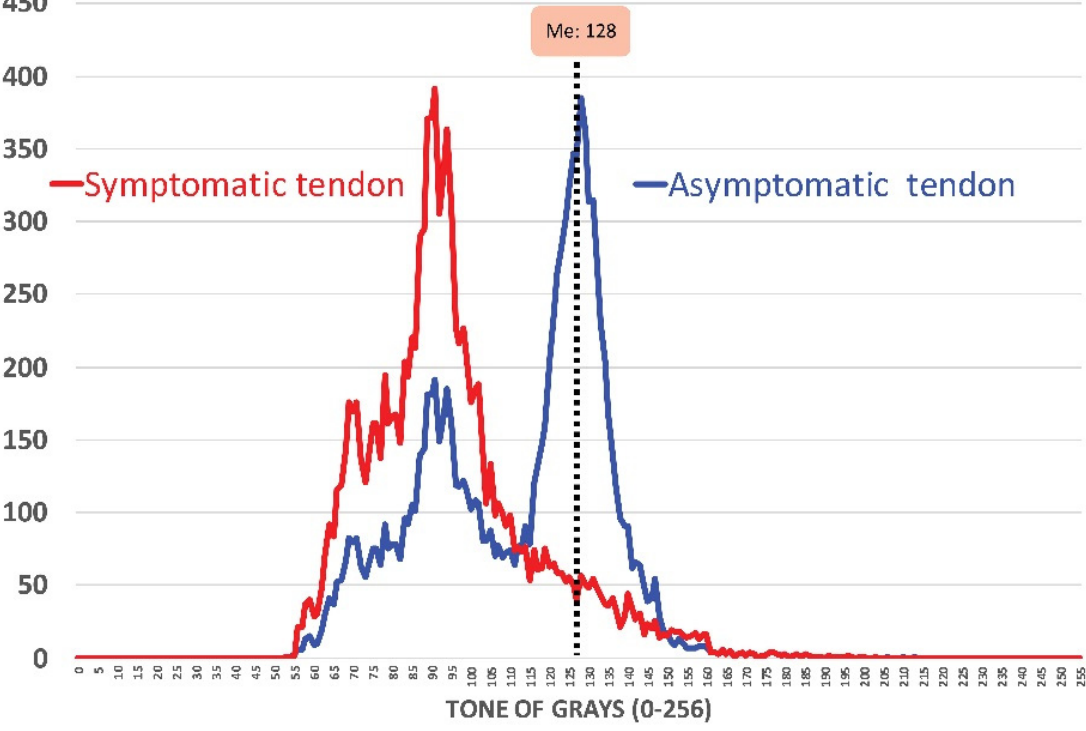
Figure 1. Tendon histogram (tone of grays) confirming the presence of hypoechoic areas in the symptomatic versus the asymptomatic tendon in non-elite sport players. Me: Median value. Exclusion criteria included: (1) bilateral knee pain symptoms; (2) previous history of surgery; (3) having received physical therapy in the last six months; (4) taking regularly medication; or (5)